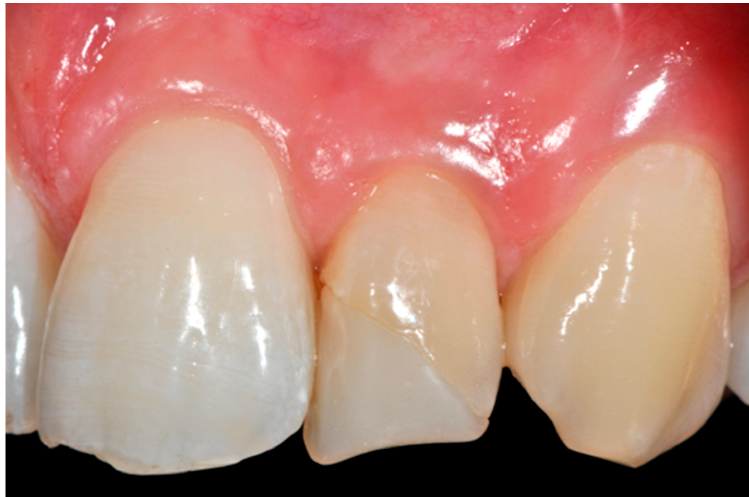
Figure 20. Initial clinical situation. Reprinted from Restauri diretti nei settori anteriori, G. Paolone, S. Scolavino, © 2021, with permission from Quintessence Publishing Italy.